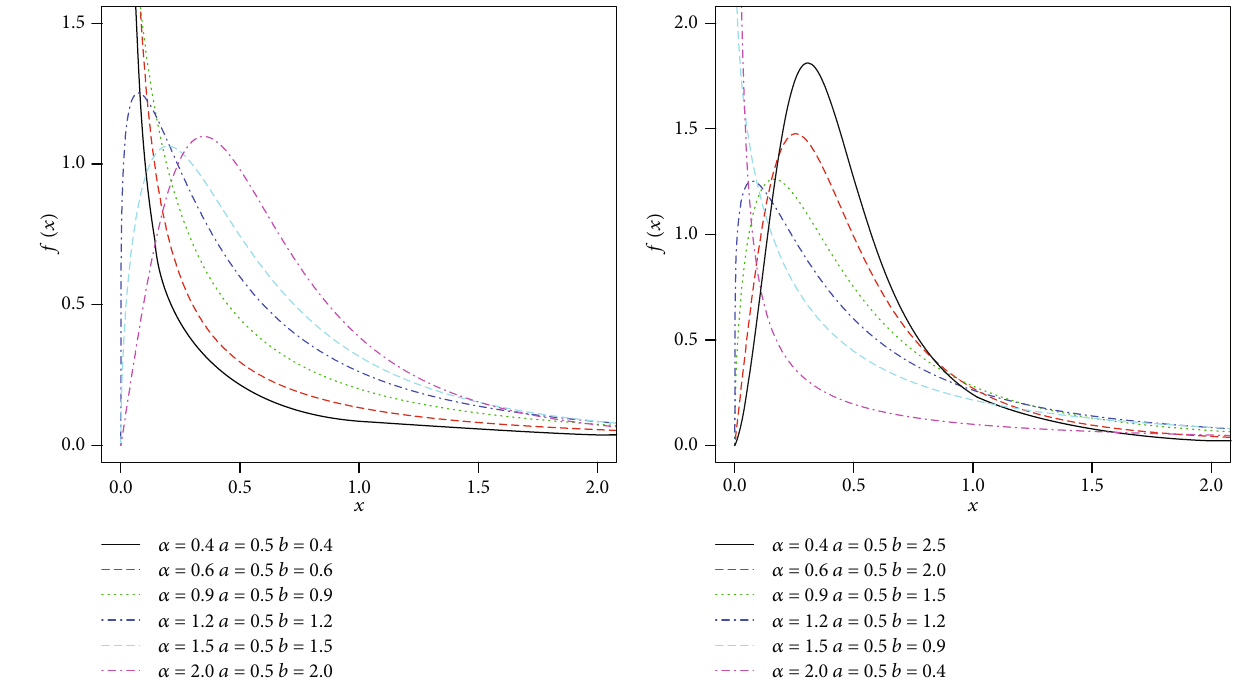
Figure 1: Plots of the pdf of the APTLL distribution.